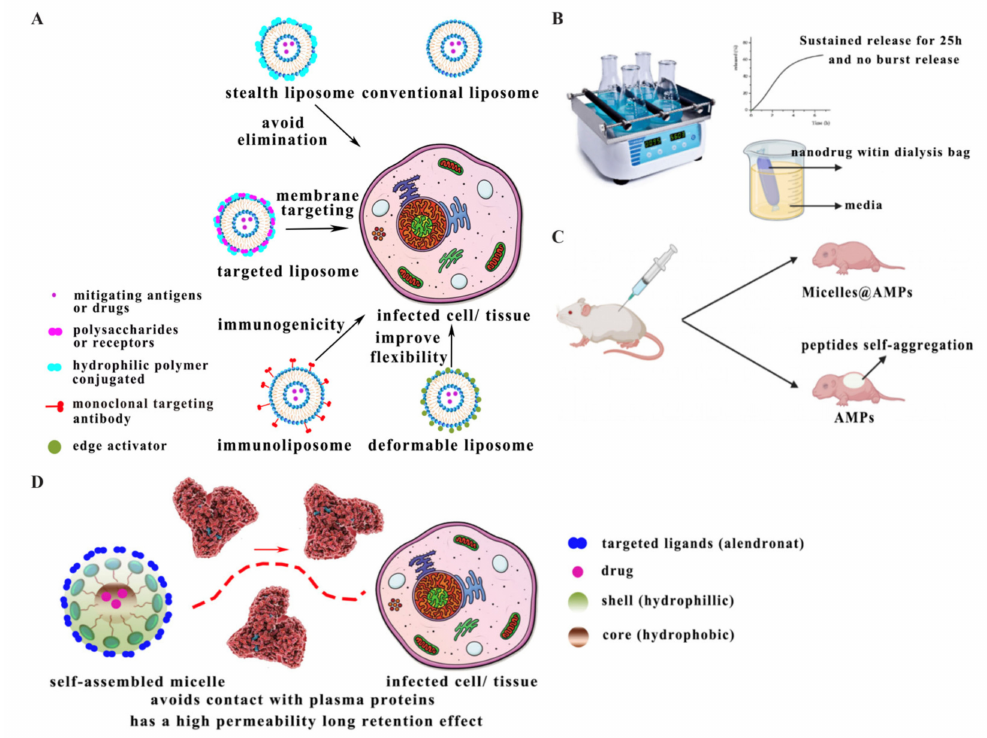
Figure 3. ( A ) Improvement strategies in liposomes adapted from [85]. ( B ) Liposomes with AMPs facilitate a sustained release rate adapted from [40]. ( C ) Micelles with AMPs avoid peptide self-aggregation adapted from [41]. ( D ) Schematic characteristics of